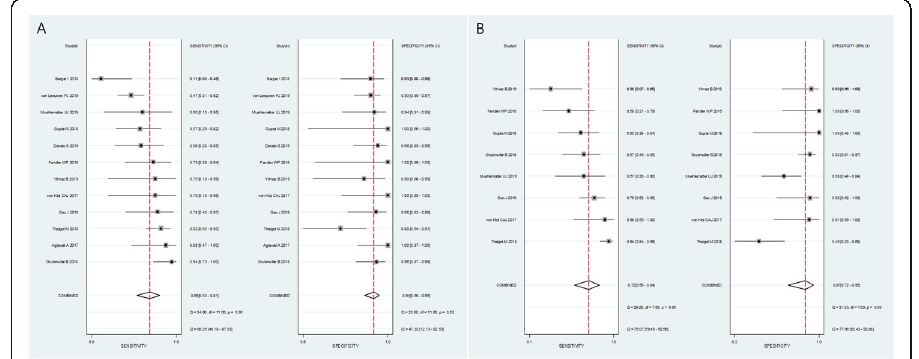
Fig. 5 Coupled forest plots of sensitivity and specificity for ( a ) seminal vesical invasion and ( b ) extraprostatic extension. Numbers are pooled estimates with 95% confidence intervals (CI) in parentheses and heterogeneity statistics are shown at the bottom right. Horizontal lines indicate 95%